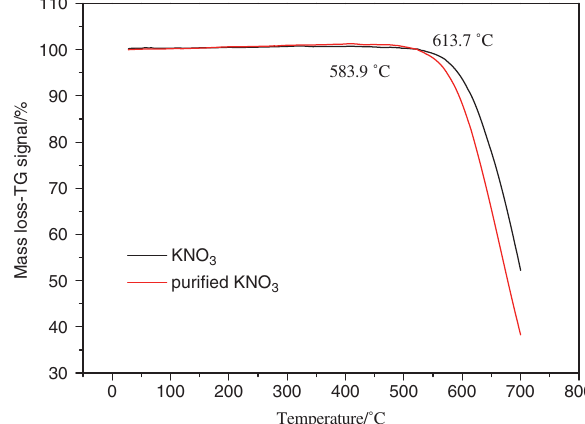
Figure 11: Latent heat of Solar Salt and purified Solar Salt after 27 h.